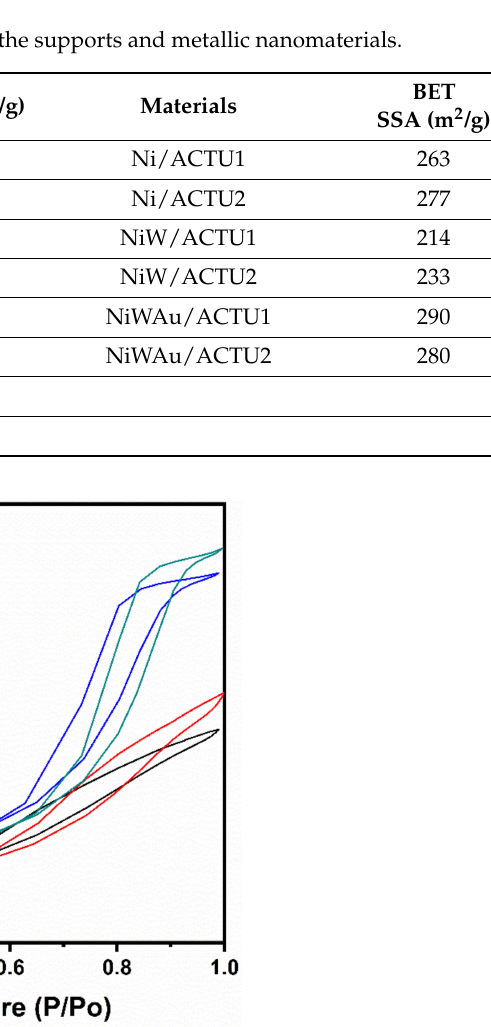
Figure 2. BET adsorption–desorption isotherms for the four supported trimetallic NPs nanomaterials.